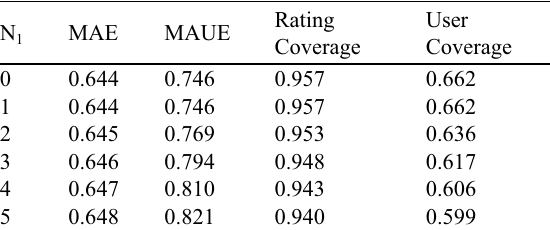
Table 5. Determine the optimized value of 1 N on Flixster.